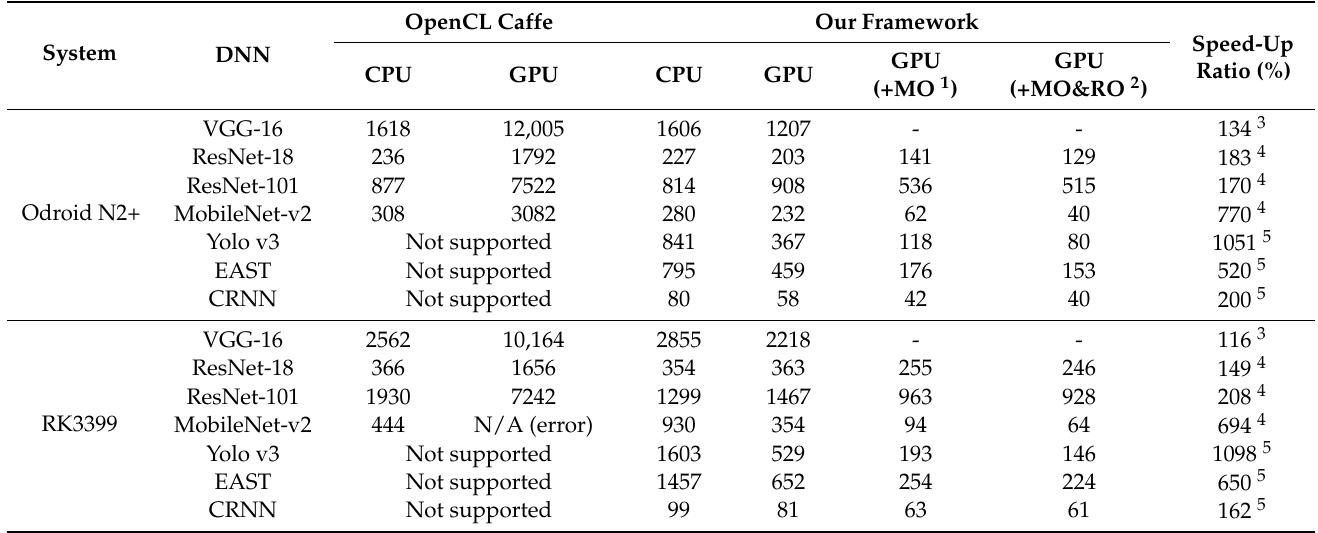
Table 6. Comparison of inference times (ms) in Odroid